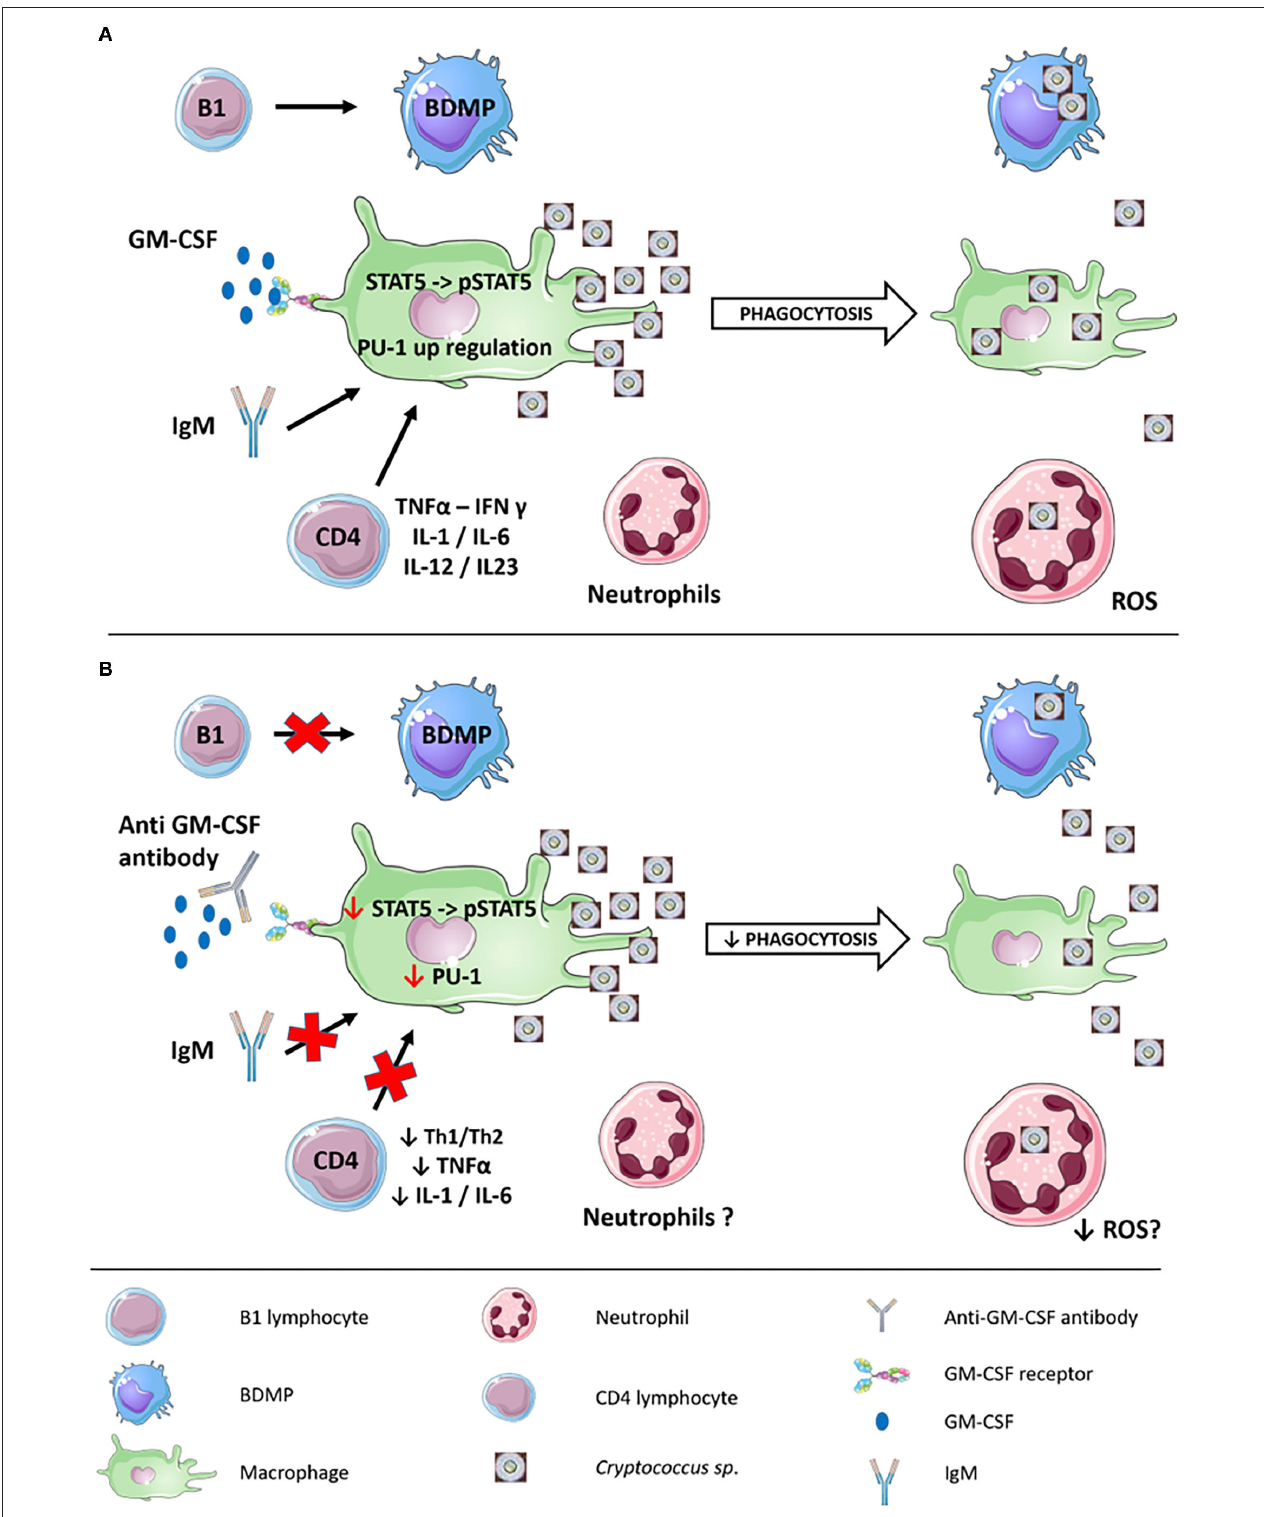
FIGURE 1 | Immune response to cryptococcal infection and potential pathophysiological mechanisms responsible for the association between sarcoidosis and cryptococcosis. (A) Immune response to cryptococcal infection involving both innate and adaptative immunity. B1 cells can differentiate into BDMP with